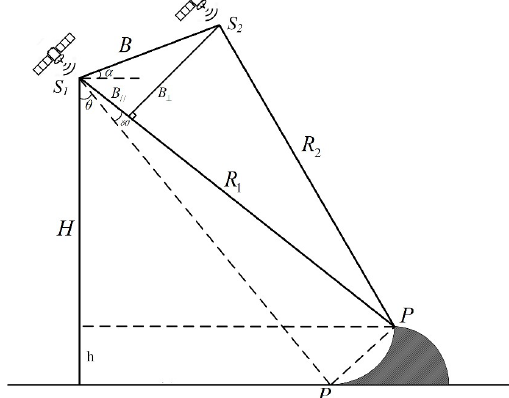
Figure 1 Geometry model calculated by InSAR technology Due to the difference in resolution between AW3D30 DEM (30 m) and TerraSAR-X/TanDEM-X images (3 m), it is possible to fail to carry out coregistration of the external AW3D30 DEM and the main image of SAR in differential interferometry.